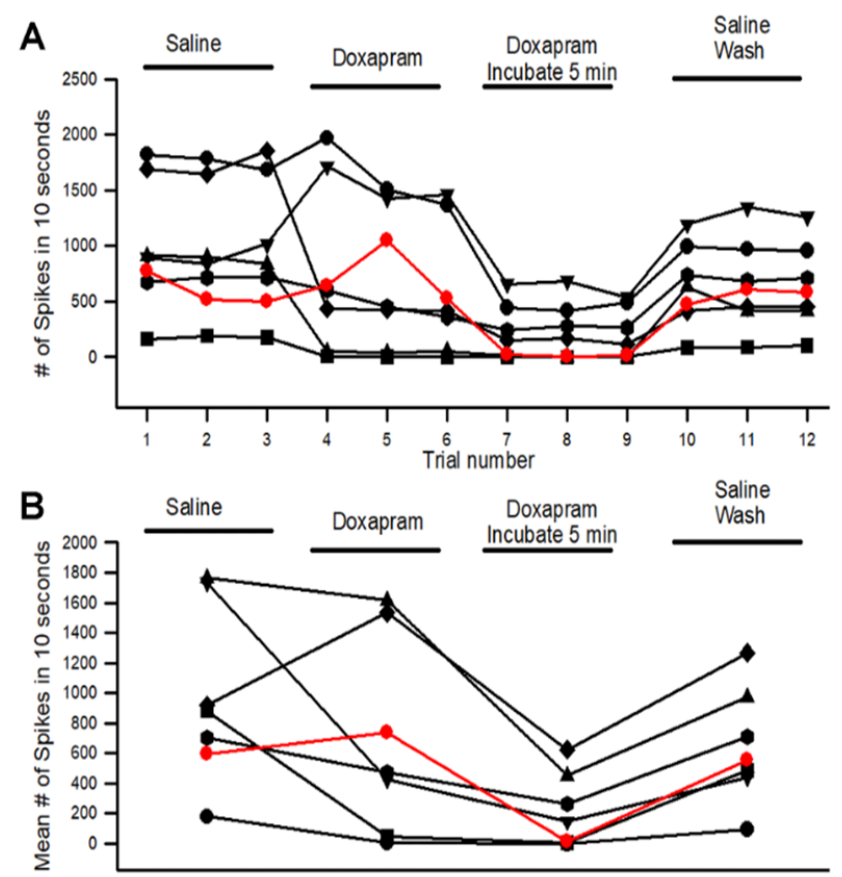
Figure 3. The acute effect of doxapram (5 mM) on neural activity of the PD organ. ( A ) The number of spikes measured in the 10-s window from the beginning movement of the joint starting from a bent position (90 degrees) to fully extended within 1 s and held in an extended position for the next 9 s. This paradigm is repeated three times for each condition. Each line represents a different preparation of an PD organ. Three trials were undertaken with saline, three trials were done immediately after switching the bath to doxapram (5 mM), and they were examined again after incubation for 5 min. The final exchange was to rinse the preparation twice with fresh saline and then move the joint three more times. Each movement was separated by at least 10 s while the joint was held in a bent position. ( B ) The number of spikes in each of the three trails was averaged and graphed in the same manner as in ( A ), which allows an easier view of the overall effects. The red colored trace represents a PD preparation from a chela of the large claw.